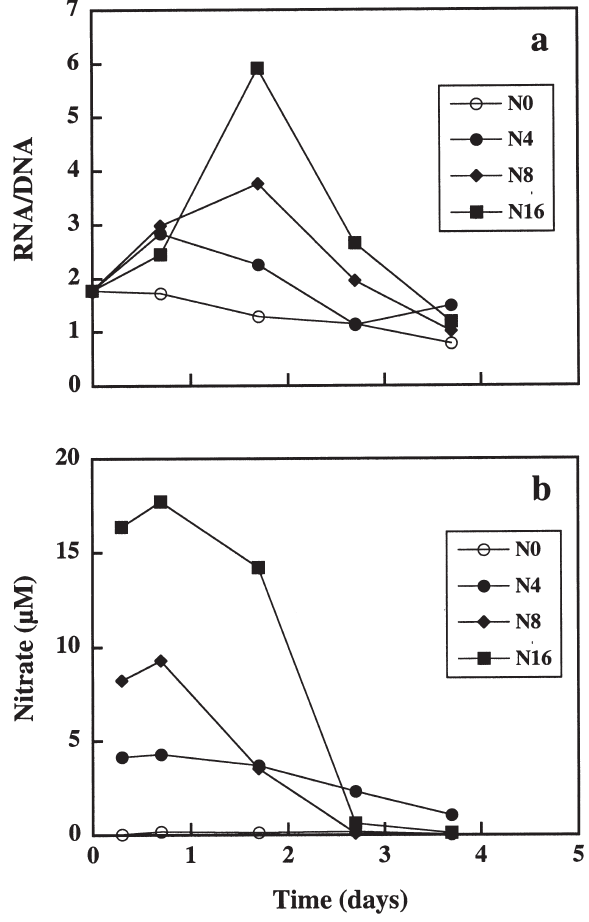
F IG . 6. – (a) Temporal variation of the RNA/DNA ratios estimated in natural microplanktonic communities enclosed in microcosms and exposed to different nutrient levels. (b) Temporal variation of the nitrate concentrations in the different treatments. N0, N4,